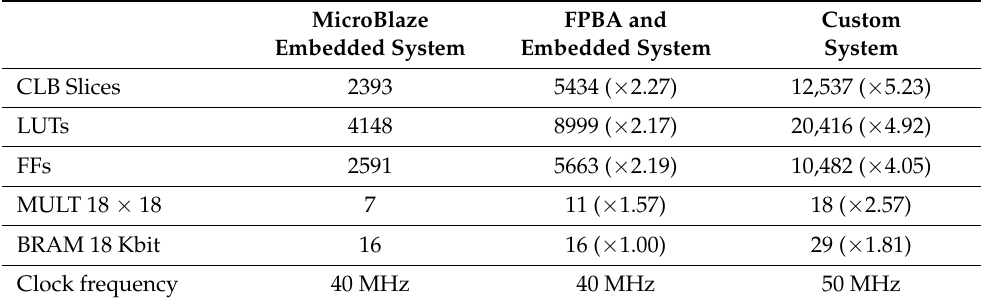
Table 4. Hardware FPGA resources (area ratio) and clock